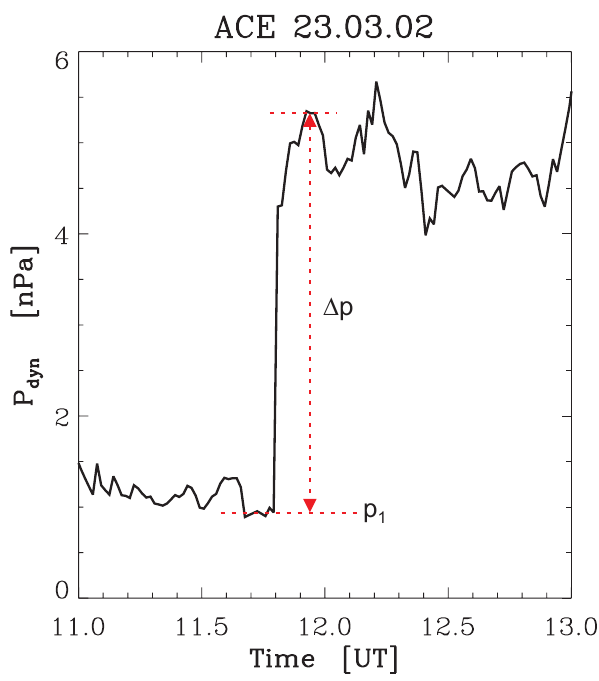
Fig. 7. Typical example of a pressure increase associated with a shock in the solar wind, measured onboard ACE. The time is prop- agated to the magnetopause (for details see Sect. 2). The quantities p 1 and 1 p are used to examine the relationship between the shock input and the caused SC magnetic deflection (listed in Table 1).